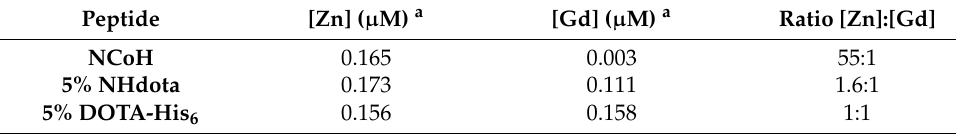
Table 1. Analysis of zinc and gadolinium ions within microflorettes by ICP-MS.